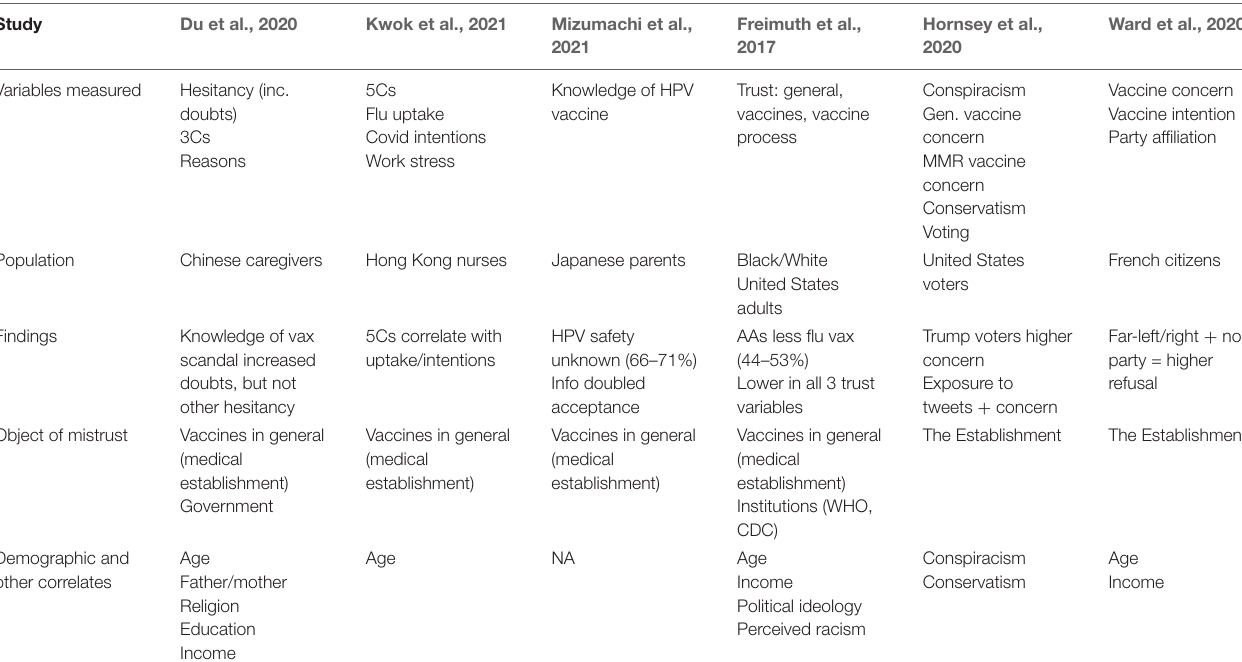
TABLE 2 | Overview of